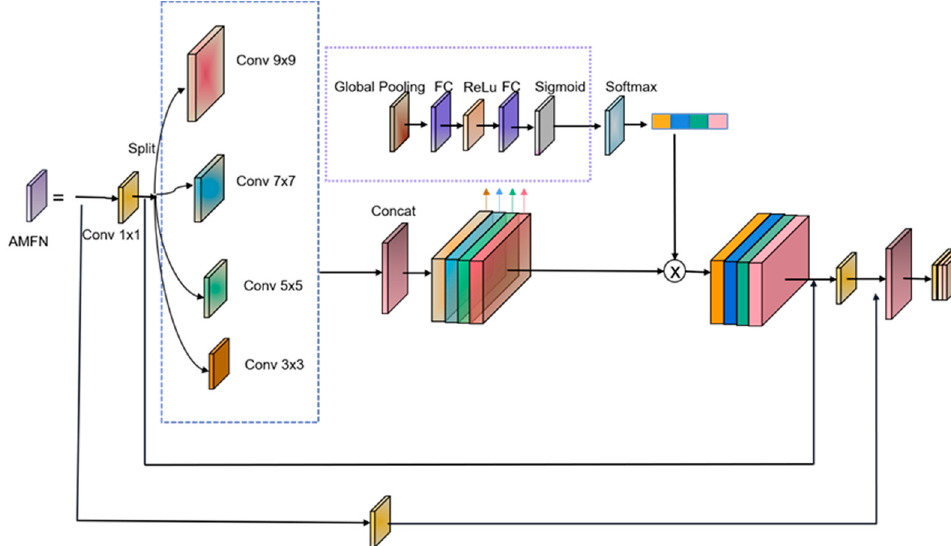
Figure 2. The architecture of AMFN (The calculation process of the AMFN backbone network. The computation process of the AMFN backbone network involves extracting feature importance through attention mechanisms, followed by weight calibration of feature maps that have undergone different convolutions and concatenation fusion using the softmax function.).